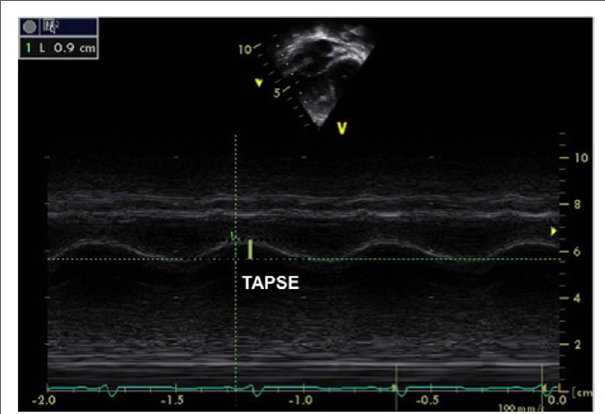
FigURe 8 | M-mode obtained from the tricuspid annulus allowing measurement of the tricuspid annular plane systolic excursion (TAPSE) in a patient with pulmonary hypertension and right ventricular (RV) dysfunction. A TAPSE value < 16 cm is indicative of RV systolic dysfunction. The same can be obtained from the mitral annulus to obtain the mitral annular plane systolic excursion.